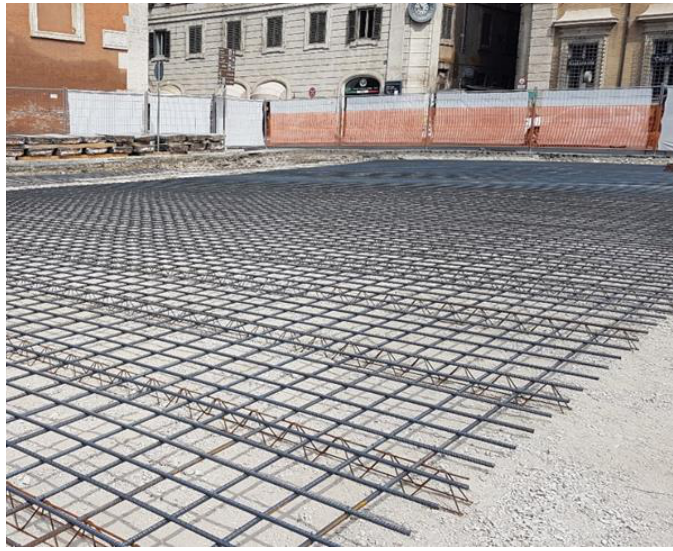
Figure 3. First phase: construction of reinforced concrete base course.